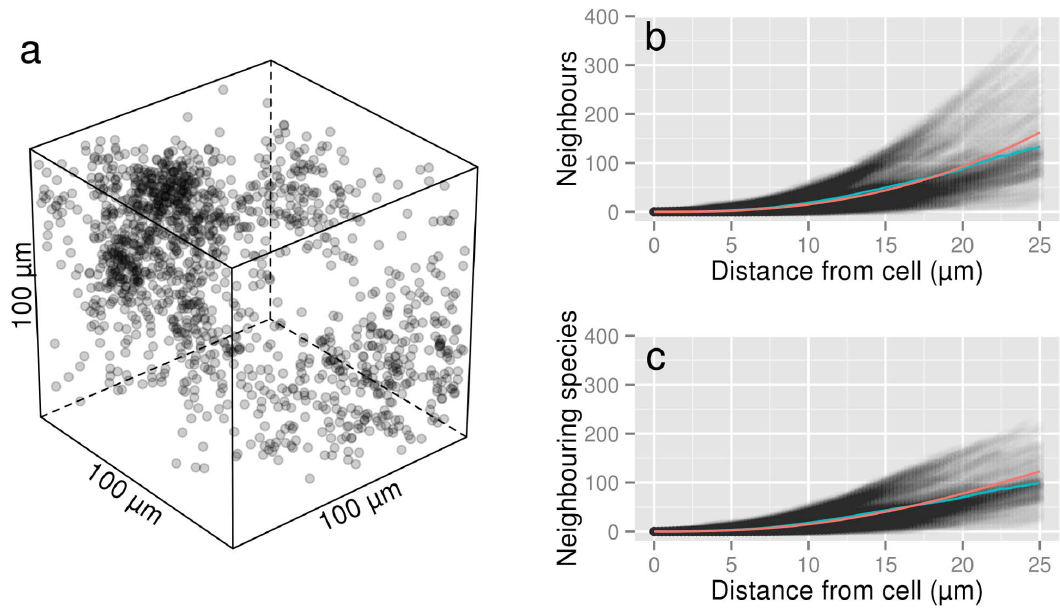
Figure 2. 3D simulation of bacterial distribution. (a) 3D representation of bacterial distribution in a 100 6 100 6 100 m m 3 cube as simulated by LGCP. The model parameters for the simulation were m = 2 7.52, s 2 =1.90 and b =25. (b) Number of neighbours as a function of distance for each bacterium (scatterplot), average number of neighbours (red line) and theoretical number of neighbours for the LGCP (blue line) and (c) Number of neighbouring species assuming a random distribution of species among individuals (line colours are the same as in b). The number of species considered in this simulation was S=450, corresponding to Fisher’s a =221.86 (estimated from [1]).